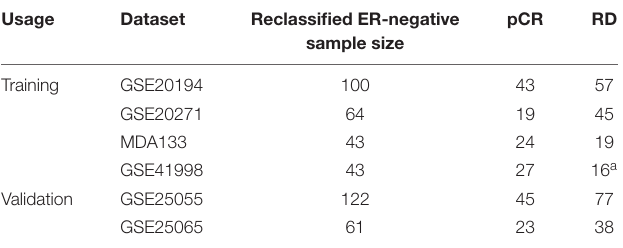
a PD and SD samples representing tumor residuals screened from RD